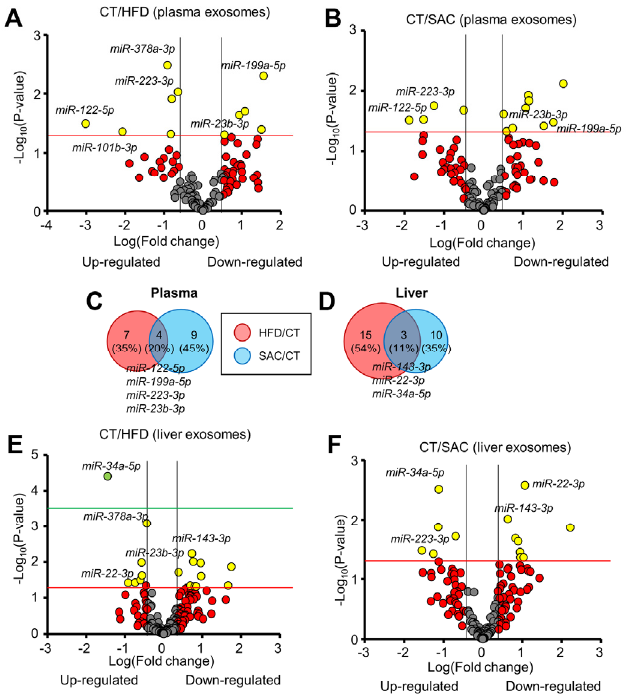
Figure 6. The miRNA profile differs between HFD and SAC plasma and liver exosomes. ( A , B ): Volcano plots show differential miRNA expression of plasma exosomes from HFD ( A ) and SAC mice ( B ) compared with CT mice. ( C , D ): Comparison of the differentially expressed exosomal miRNAs in HFD/CT and SAC/CT in plasma ( C ) and liver ( D ). ( E , F ): Volcano plots show differential miRNA expression of liver exosomes from HFD ( E ) and SAC mice ( F ). n = 3/group ( A – C ) and n = 4/group ( D – F ).